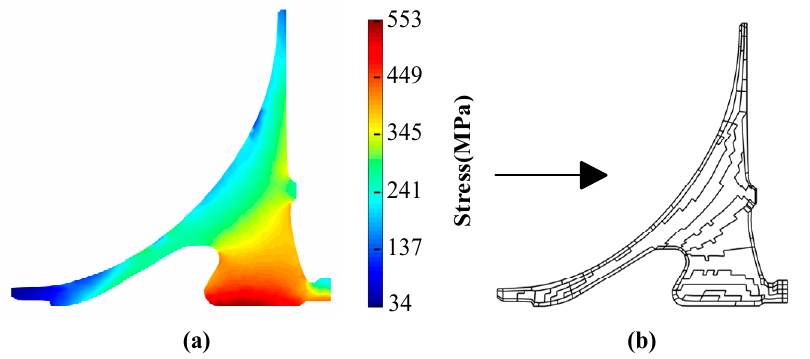
Figure 11. Stress contours and zone definition: ( a ) Circumferential stress contours; ( b ) Zone defini ‐ tion.